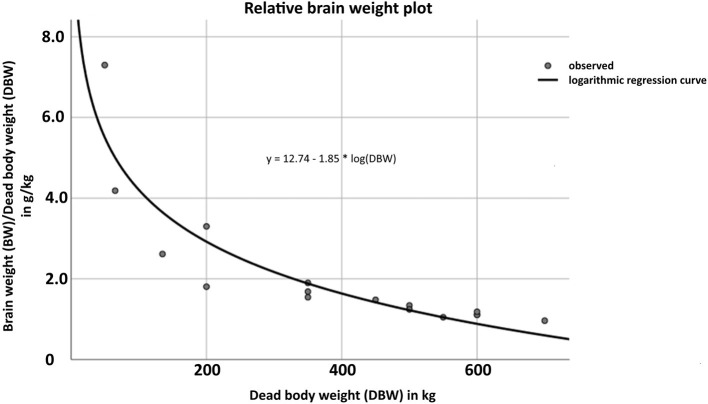
Demonstration of the logarithmic, non-linear relationship (logarithmic regression curve) between dead body weight (DBW) in kg (x-axis) and brain weight (BW) post fixation in g (y-axis) according to the formula y = 12.74 – 1.85 * log(DBW). Details of individual cases are shown in Supplementary Table 4 (Data Sheet 2).